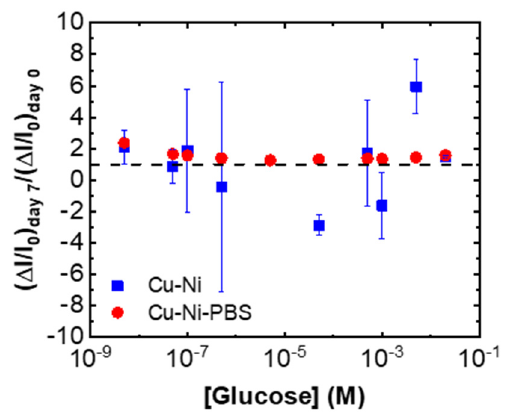
Figure 6. PBS treatment is essential for sensor stability. The oxidation current ( ∆ I/I 0 ) on day 7 normalized to the initial signal (on day 0) over the entire sensor dynamic range (5 nM–20 mM) at a potential of 0.21 V. The sample was stored in ambient condition. Error bars represent standard error of 3 CV scans from 2–3 distinct sensors. The dashed line represents the ideal sensor stability, i.e., when day 7 signal equals that of day 0.